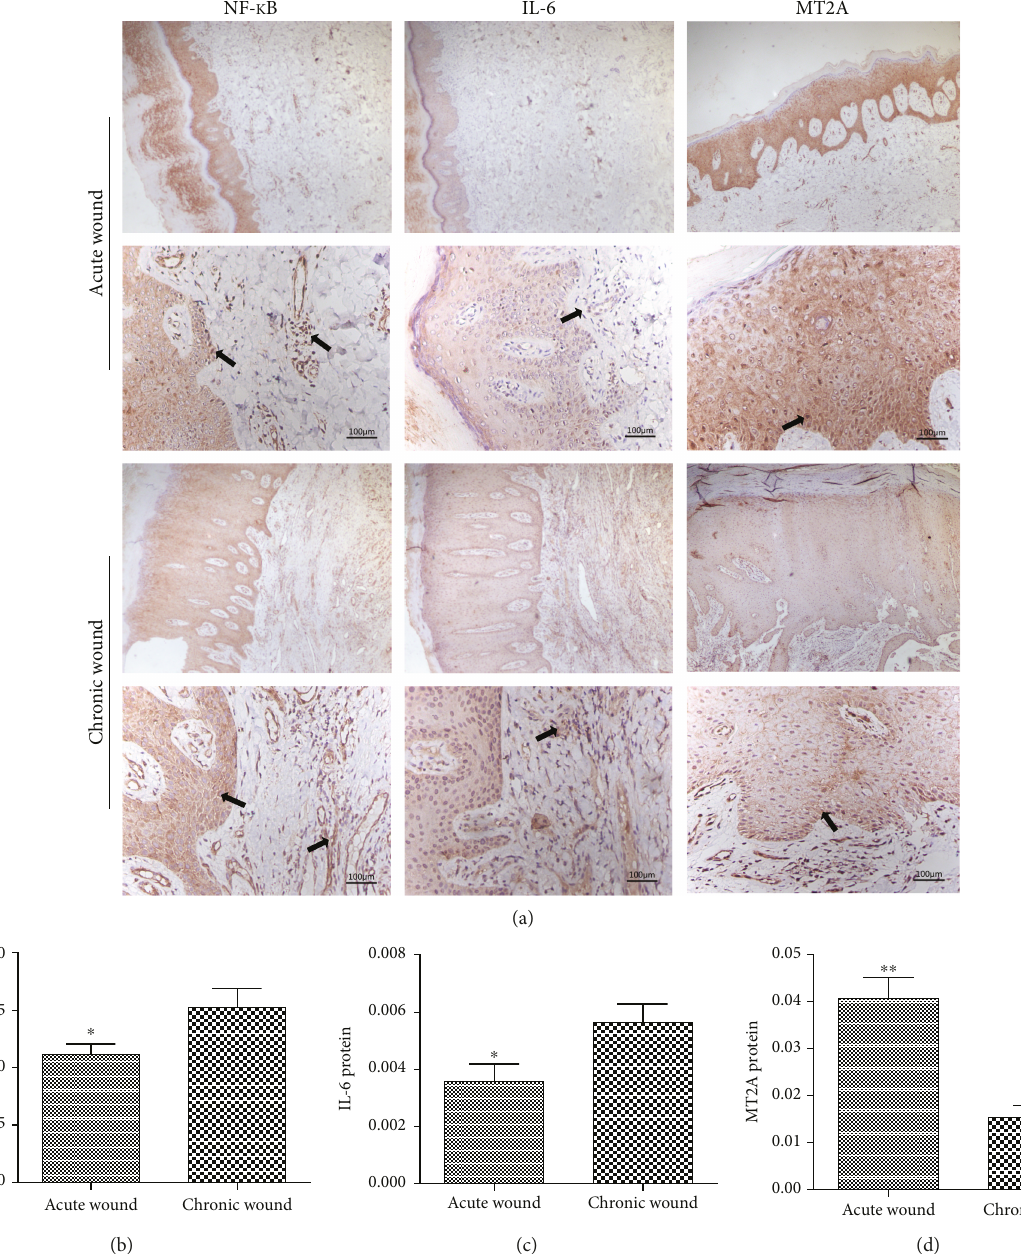
Figure 3: Expression of NF- κ B, IL-6, and MT2A in the epidermis of diabetic foot skin tissues. (a) Immunohistochemical analysis of NF- κ B, IL-6, and MT2A in the diabetic foot skin tissues. The yellowish-brown color denotes the positive areas. Scale bar: 100 μ m. The quantitative analyses of NF- κ B (b), IL-6 (c), and MT2A (d) expression were performed through measuring the mean density. ∗ P < 0 05 , ∗∗ P < 0 01